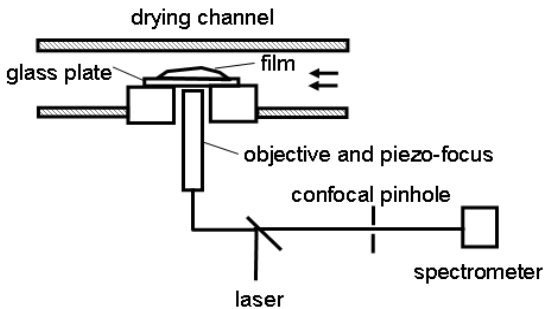
Fig. 3 schematic setup of RMS method 17)